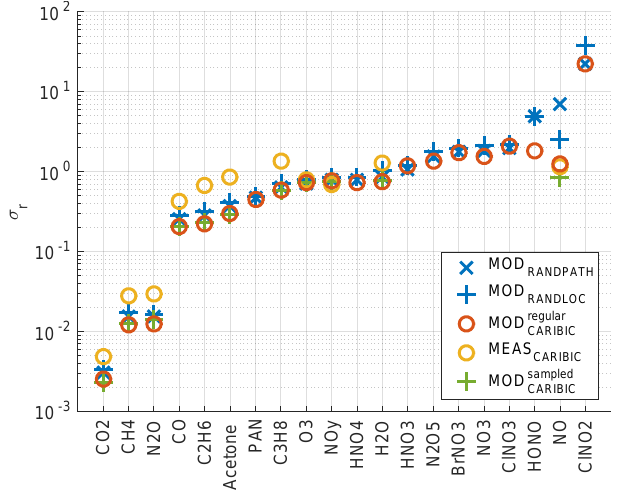
Figure 2. Variability σ r calculated for different datasets using Eq. (1). The species are sorted by σ r and species with low vari- ability are listed to the left, using the values from MOD RANDPATH for sorting. Note that log 10 (σ r ) = τ ∗ , see Eq.